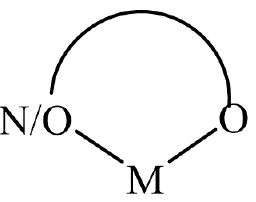
Figure 11. Coordination modes for the flavonoids complexes.